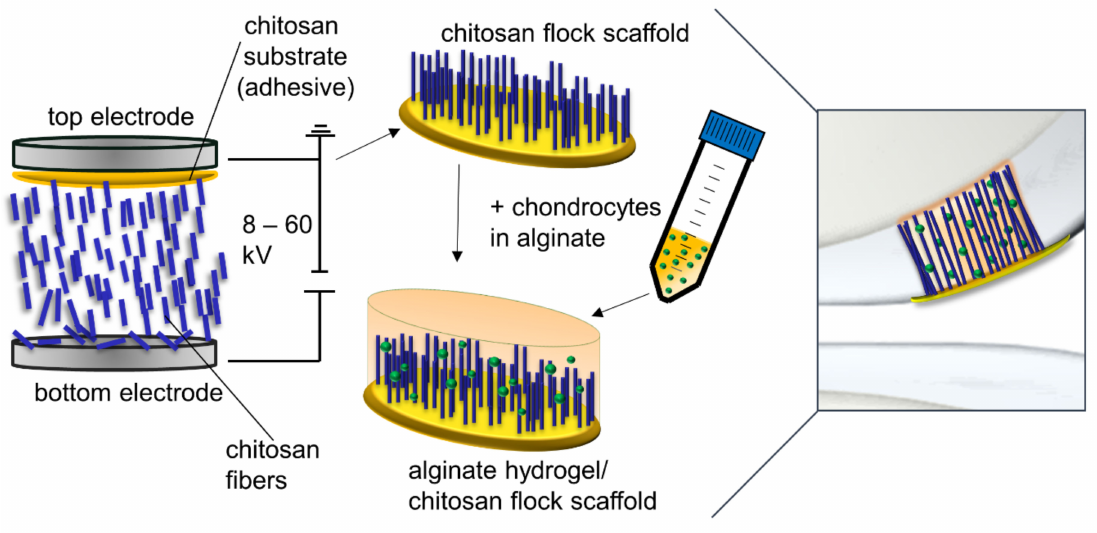
Figure 1. Principle of electrostatic flocking and scaffold production for chondrogenic tissue engineering. In an electrical field, 2 mm short wet spun chitosan fibers, at the beginning located on the bottom electrode, are shot vertically into a highly viscous chitosan layer covering the top electrode, which acts simultaneously as adhesive and substrate for the fibers. After drying, neutralization, and sterilization, the flock scaffold is seeded with chondrocytes in an alginate sol. The cells are immobilized after crosslinking in the combined alginate hydrogel/chitosan flock scaffold. After differentiation of the embedded cells, the scaffold is placed in a cartilage